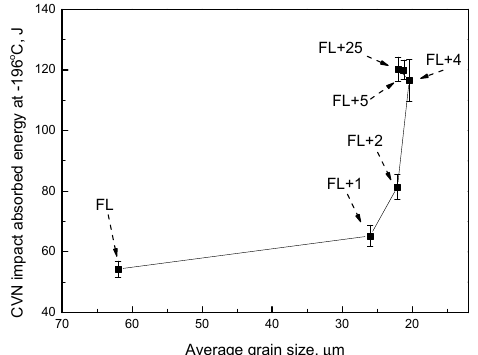
Figure 8. The correlation of cryogenic Charpy V-notch impact absorbed energy and average grain size at different locations of HAZ.